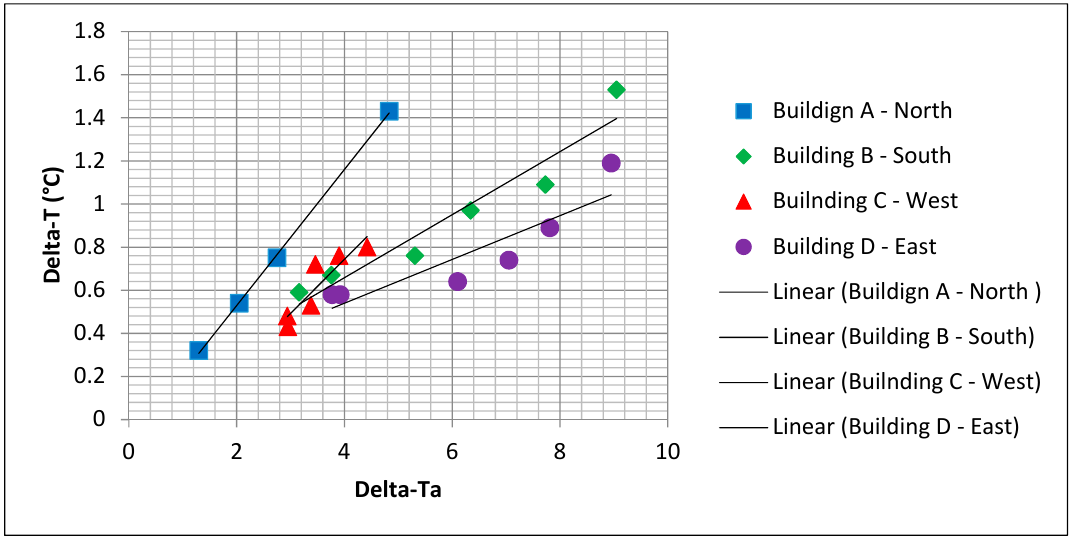
Figure 2. Comparison between Delta-T and